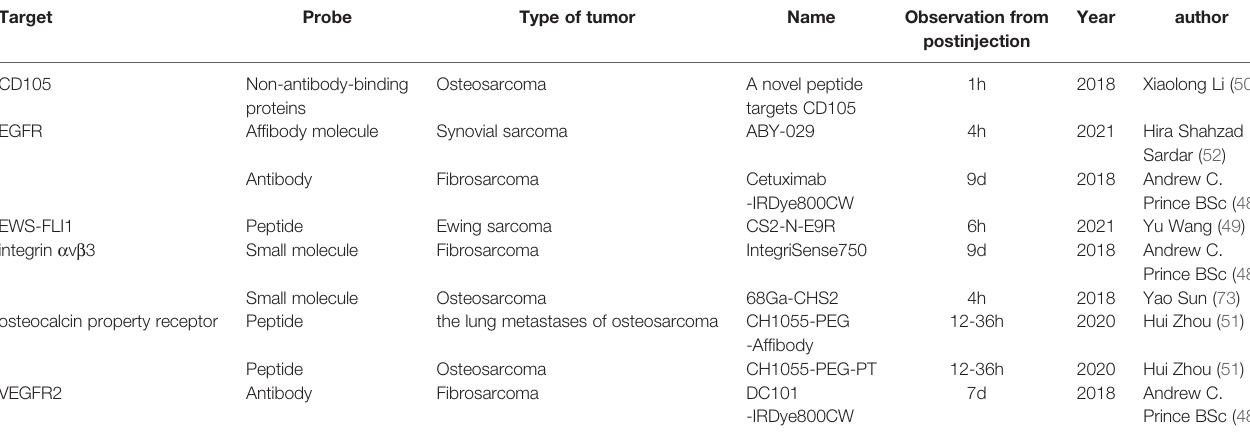
TABLE 1 | Speci fi c fl uorescent probes for bone and soft tissue tumor